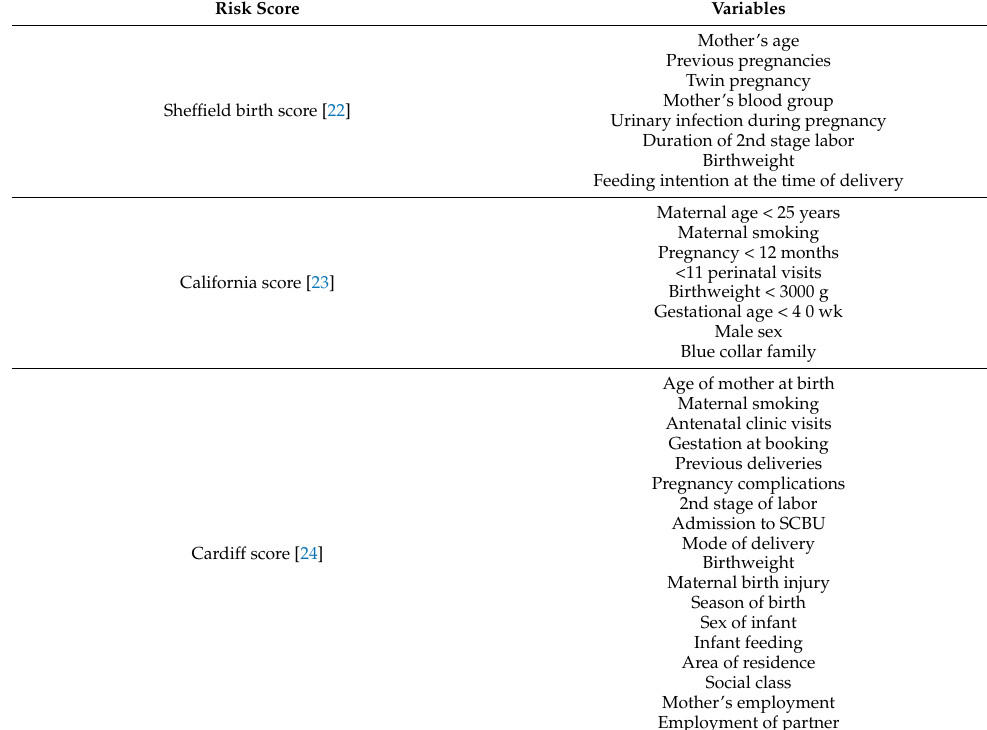
Table 1. SIDS Risk Scores from the